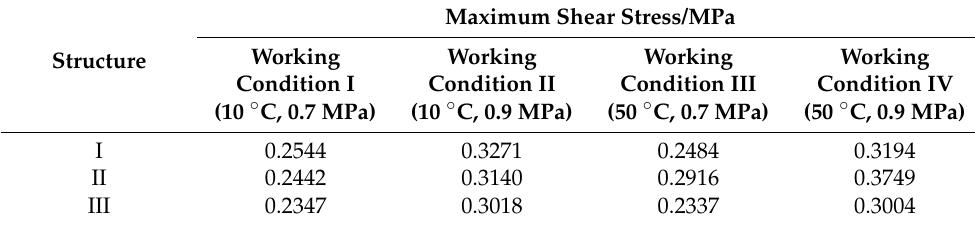
Table 6. Upper layer bottom maximum shear stress